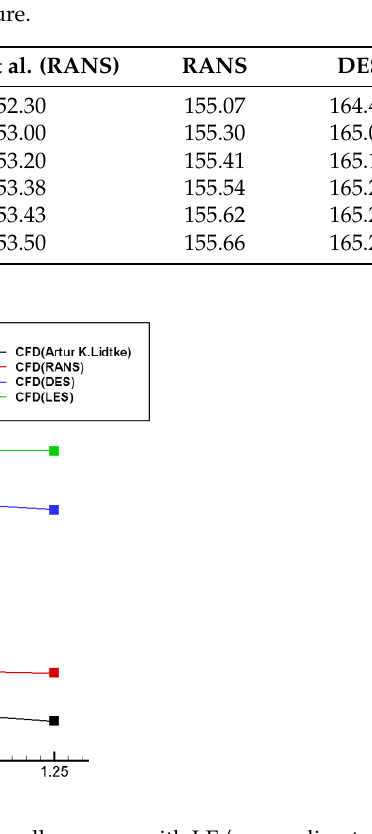
Figure 10. Sound pressure level (SPL) of wall pressure with LE/c according to turbulence model.